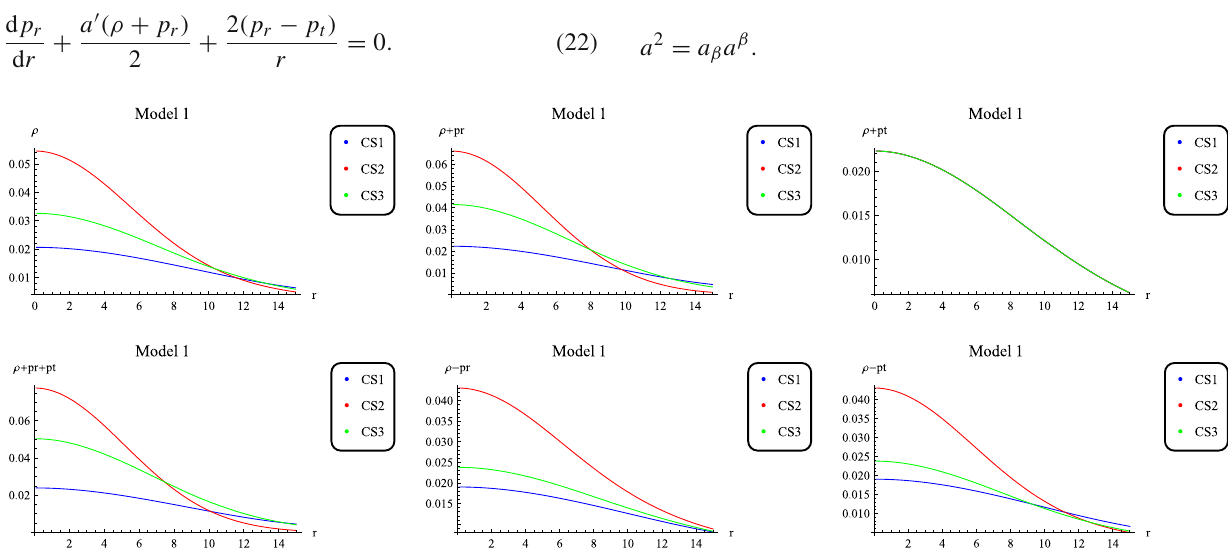
Fig. 7 Viability of energy conditions for three different strange stars with dark source terms coming from f ( R ) = R + α R